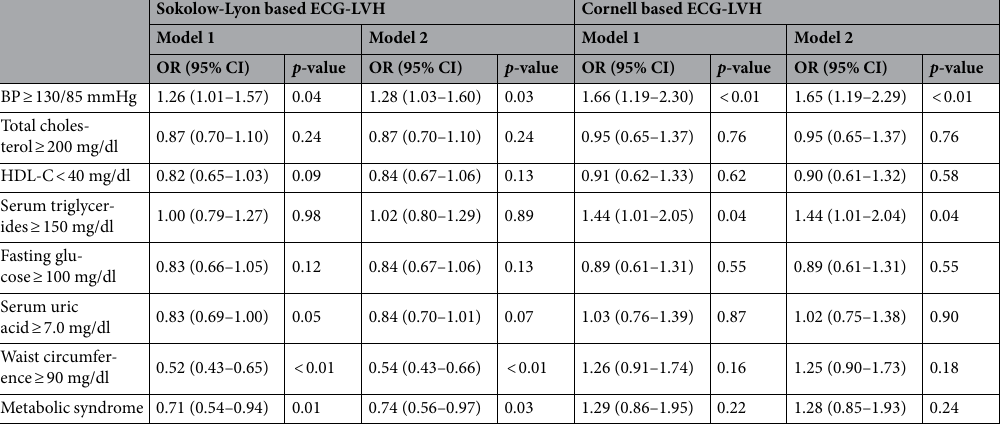
Table 4. Associations between Cardiometabolic Risk Factors and Electrocardiographic Left Ventricular Hypertrophy in Men. Multiple logistic regressions were used to determine the association of cardiometabolic risk factors with electrocardiographic LVH. Model 1 adjusted for age, BP ≥ 130/85 mmHg, total cholesterol ≥ 200 mg/dl, HDL-C < 40 mg/dl, serum triglycerides ≥ 150 mg/dl, fasting glucose ≥ 100 mg/dl, serum uric acid ≥ 7.0 mg/dl, waist circumference ≥ 90 mg/dl, metabolic syndrome status, cigarette smoking status and alcohol intake status. Model 2 adjusted for the covariates in model 1 and 3000-m running time. BP Blood pressure, HDL-C High-density lipoprotein cholesterol, LVH Left ventricular